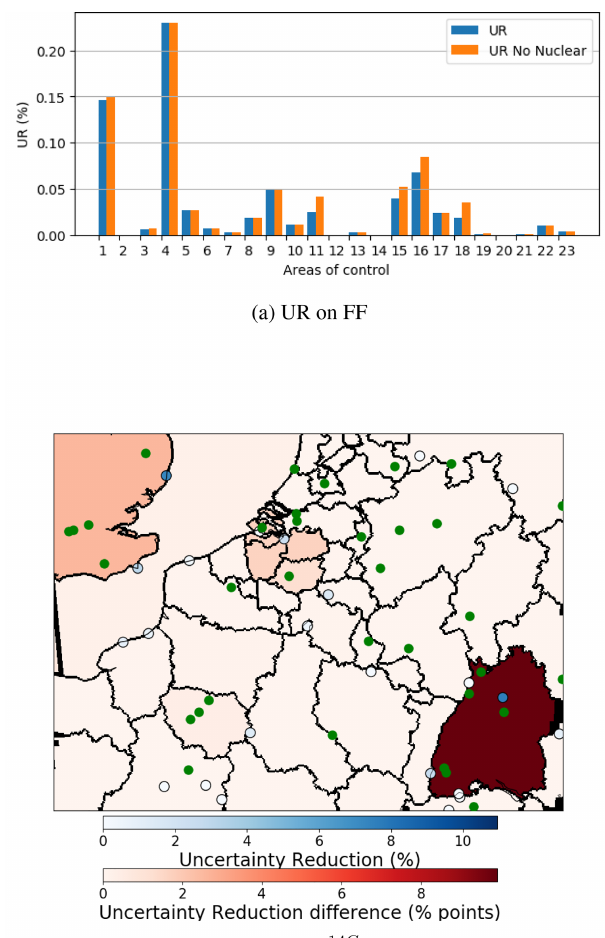
Figure A7. (a) Uncertainty reductions, on 24h FF budgets, with and without nuclear emissions in INV-14C inversion, for each con- trolled area in the main area of interest. The names of the controlled areas are listed in Table 1. (b) Maps of the 2km resolution area of the differences between uncertainty reductions with and without nuclear emissions (shades of red) in INV-14C inversions and un- certainty reductions on F 14 C nuclear power plant budgets ( F Nucl in the main text) (dots, shades of blue). Green dots indicate the ground